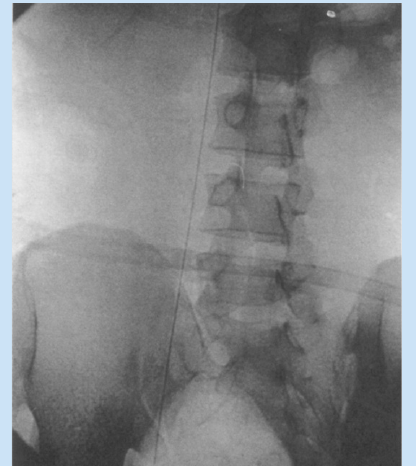
Fig. 4a. Lost guidewire in IVC.